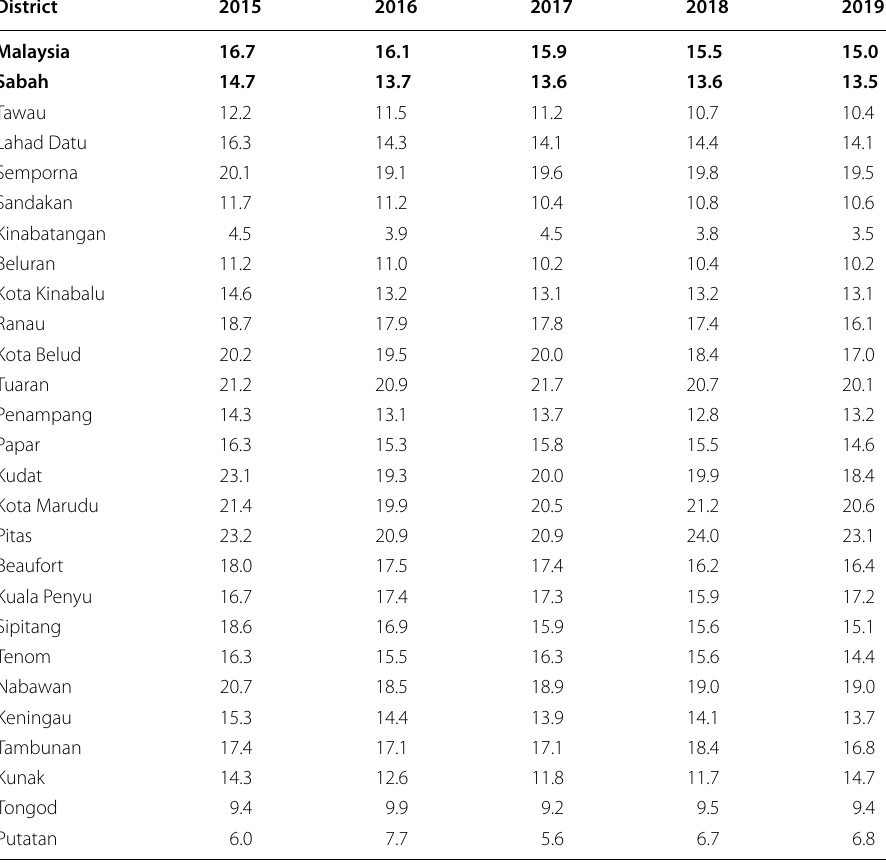
The bold values show the overall values for Malaysia (country as a whole) and Sabah (state as a whole) Sources: Vital statistics, Malaysia, 2017–2020; My local stats, Sabah, 2017 (DOSM, 2017, 2018a, c, 2019, 2020f)